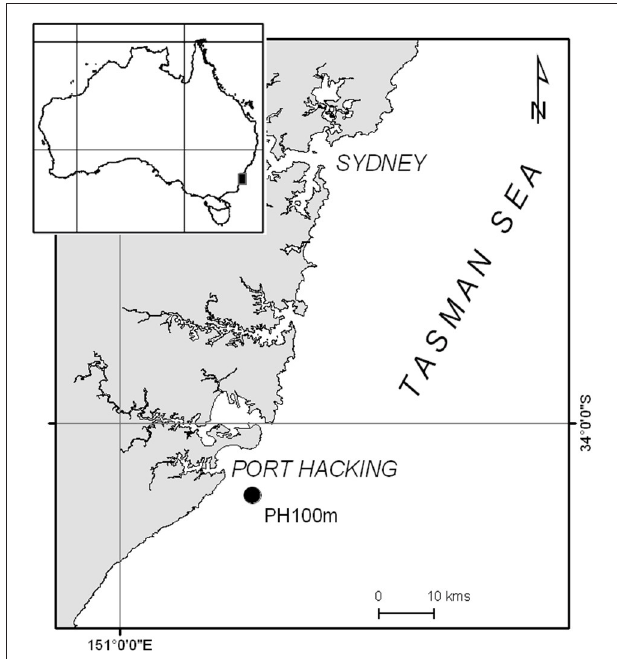
FIGURE 1 | Map of study area showing southeast Australia (inset) and the coastal monitoring station Port Hacking 100m (PH 100m ) indicated by black